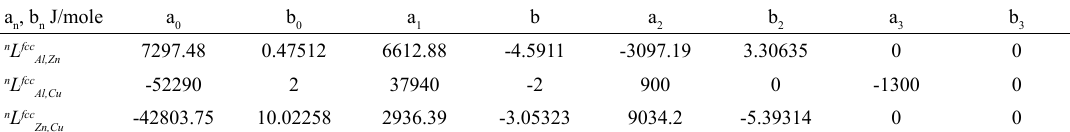
Table 1. Thermodynamic constants for the Al-Cu-Zn system 3